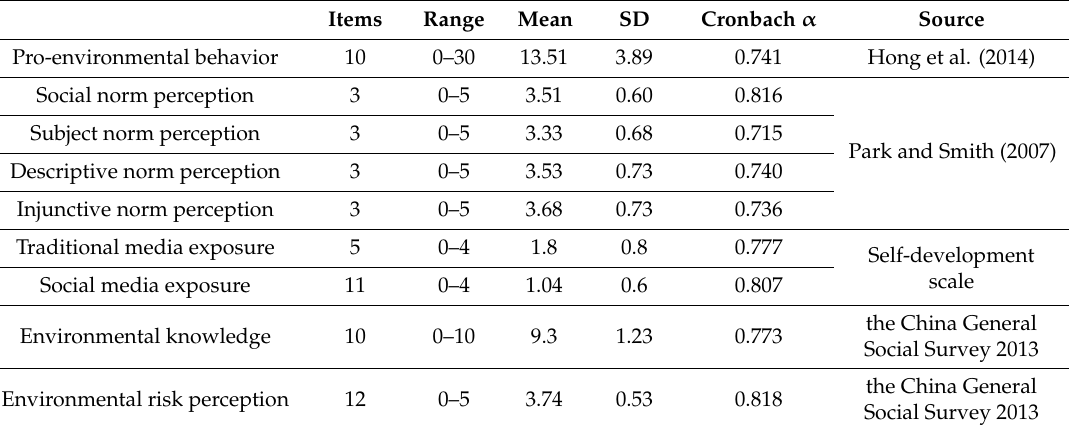
Table 1. Source and Statistics of main